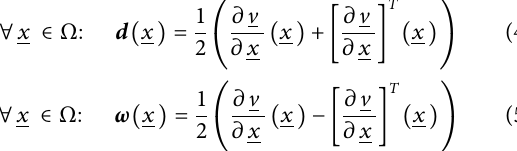
Frontiers in Bioengineering and Biotechnology |